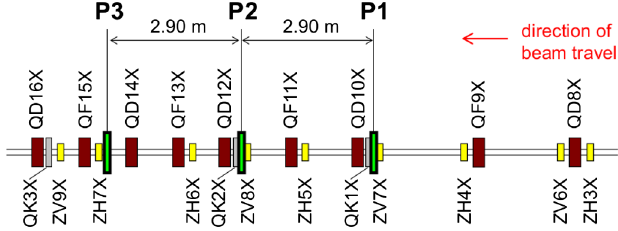
FIG. 2. Layout of the FONT5 BPMs (P1, P2 and P3) in the ATF2 extraction line; quadrupole ( “ Q ” ) and dipole corrector ( “ Z ” ) magnets are indicated.